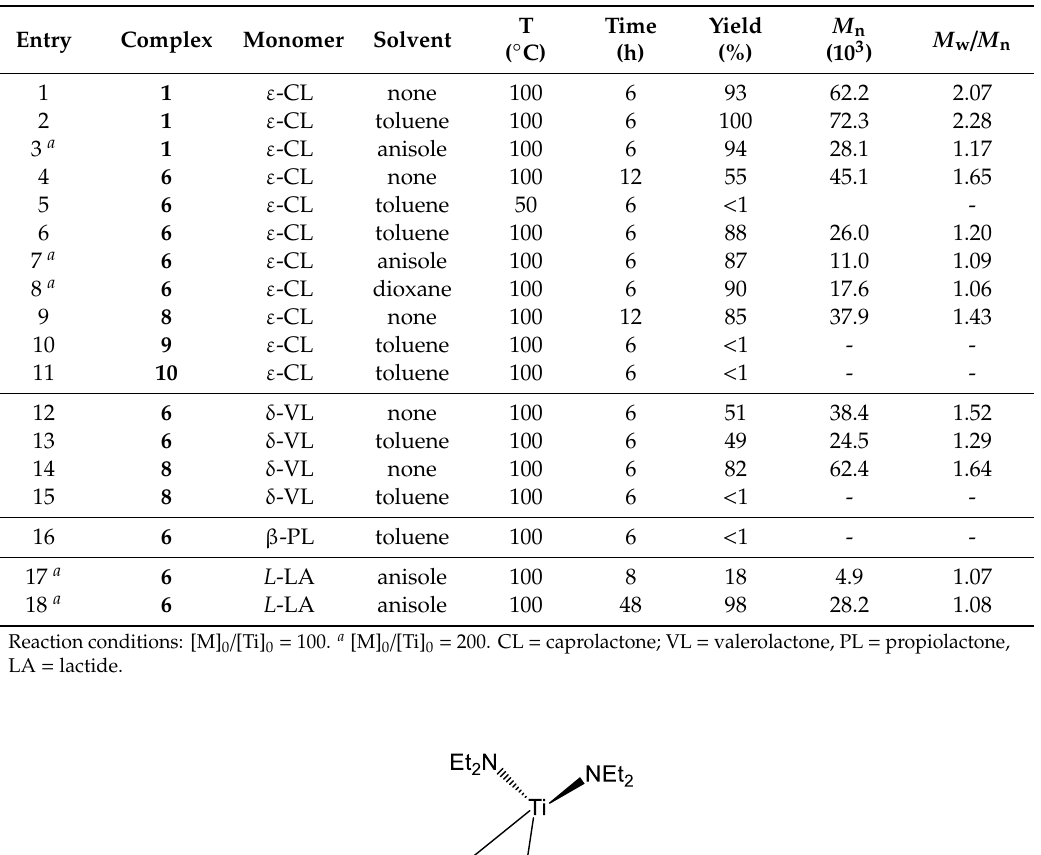
Table 13. ROP of cyclic esters catalyzed by titanium-diphenolate complexes [24].